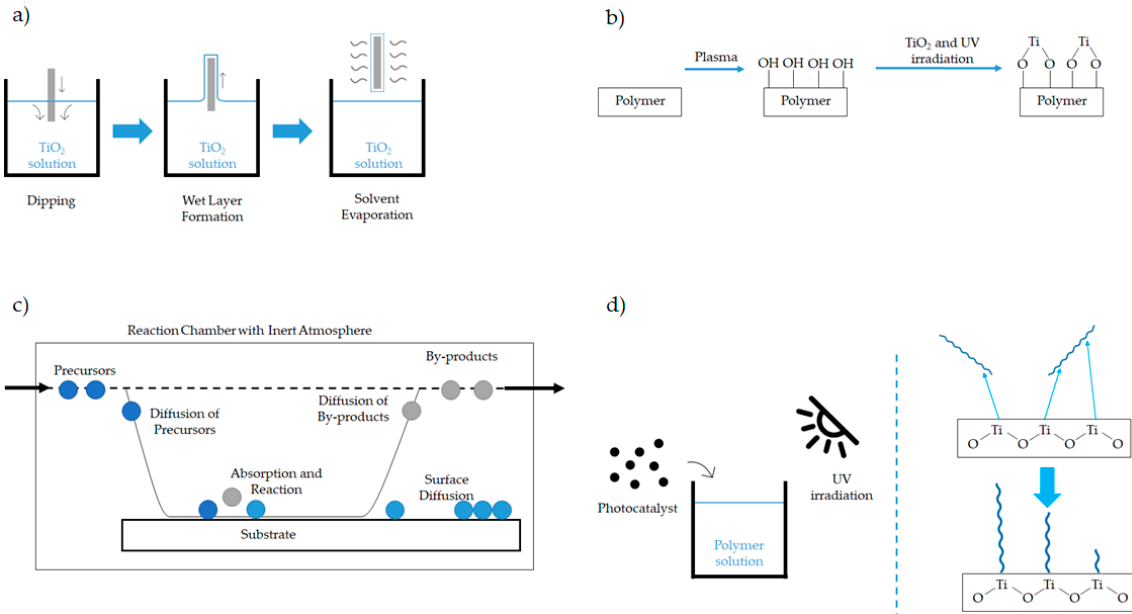
Figure 1. Schematic representation of the immobilization process on the surface by ( a ) dip-coating, ( b ) plasma treatment followed by UV irradiation, ( c ) chemical vapor deposition, and ( d ) grafting.